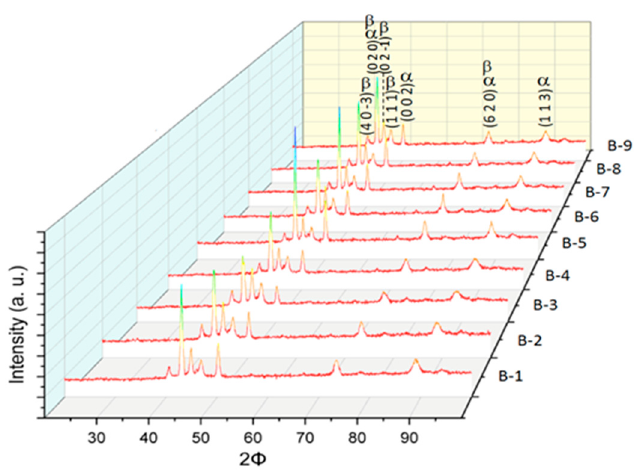
Figure 4. X-ray di ff raction (XRD) of the nine variations of oxygen and acetylene pressures for Figure 4. X-ray diffraction (XRD) of the nine variations of oxygen and acetylene pressures for aluminum–bronze coatings. aluminum–bronze coatings.